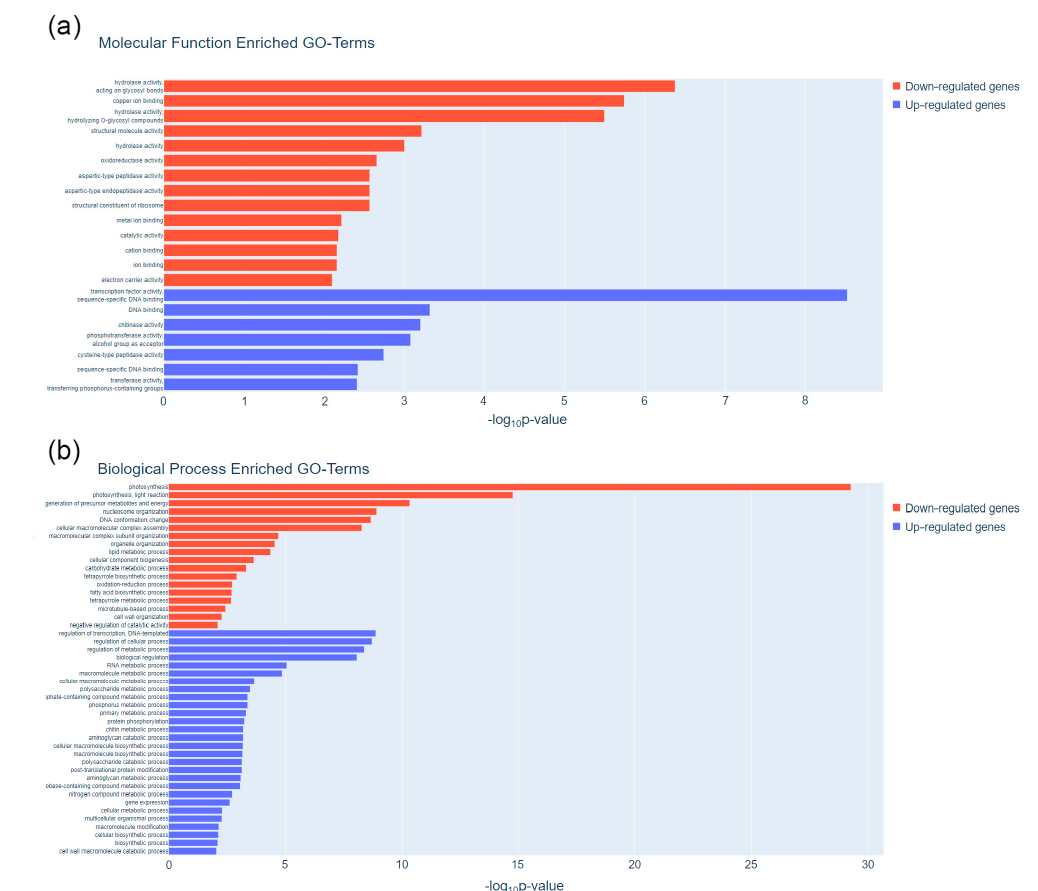
Figure 4. Curated list of significantly enriched GO terms for ( a ) Molecular Function and ( b ) Biological Process categories in down-regulated (red) and up-regulated (blue) candidate maturation genes. Significance scores were calculated as the -log10 of the p -value. The full list of significantly enriched GO terms is available in Tables S3.1 and S3.2.